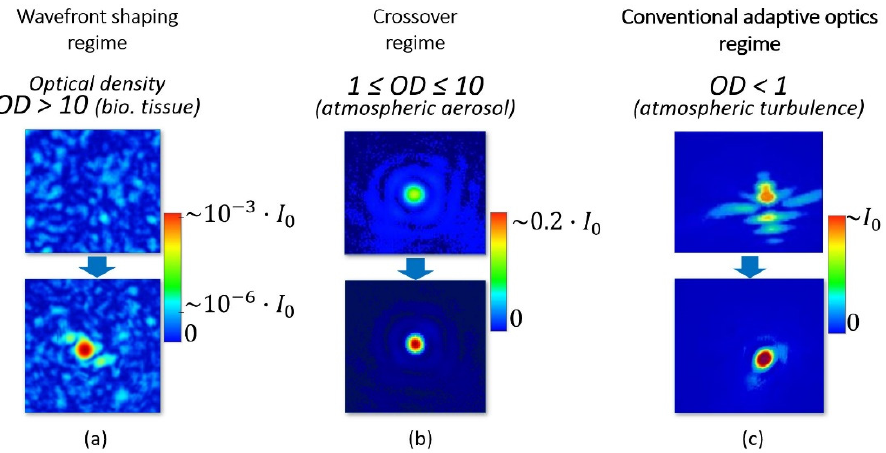
Figure 1. Intensity distributions of the focal spot at the camera sensor placed at the focal plane of a focusing lens for different optical density values of the medium: ( a ) Wavefront shaping regime (image adapted from I. Vellekoop, Optics Letters 32(16), 2007); ( b ) crossover regime; ( c ) conventional adaptive optics regime (image adapted with permission from J. Sheldakova et.al., Proc. SPIE 4969 , 2003).